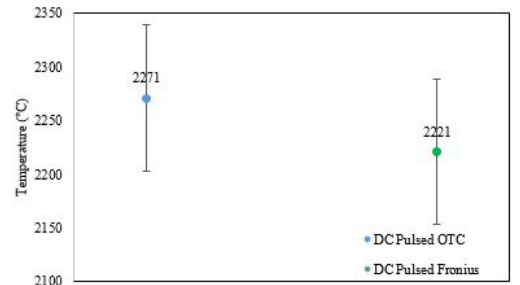
Figure 11. Droplet temperature - Fronius and OTC Pulsed GMAW.